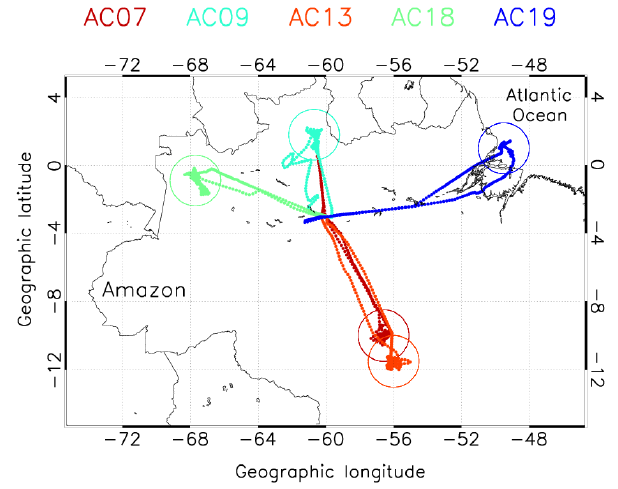
Figure 1. HALO flight tracks during the ACRIDICON–CHUVA experiment. The flight number is indicated at the top by colors. Colored circles indicate the region of cloud profiling in each flight. Convective clouds formed in clean air masses were found above the Atlantic Ocean during flight AC19 (shown in blue). Clouds in lightly pollution conditions were found during flights AC09 and AC18 over the tropical rain forest (shown in green). Polluted clouds forming in deforested regions were measured during flights AC07 and AC13 (shown in red and orange, respectively). The average aerosol particle concentrations measured near cloud bases during flights AC07, AC09, AC13, AC18, and AC19 were 2498, 821, 4093, 744, and 465cm − 3 , respectively (Cecchini et al.,